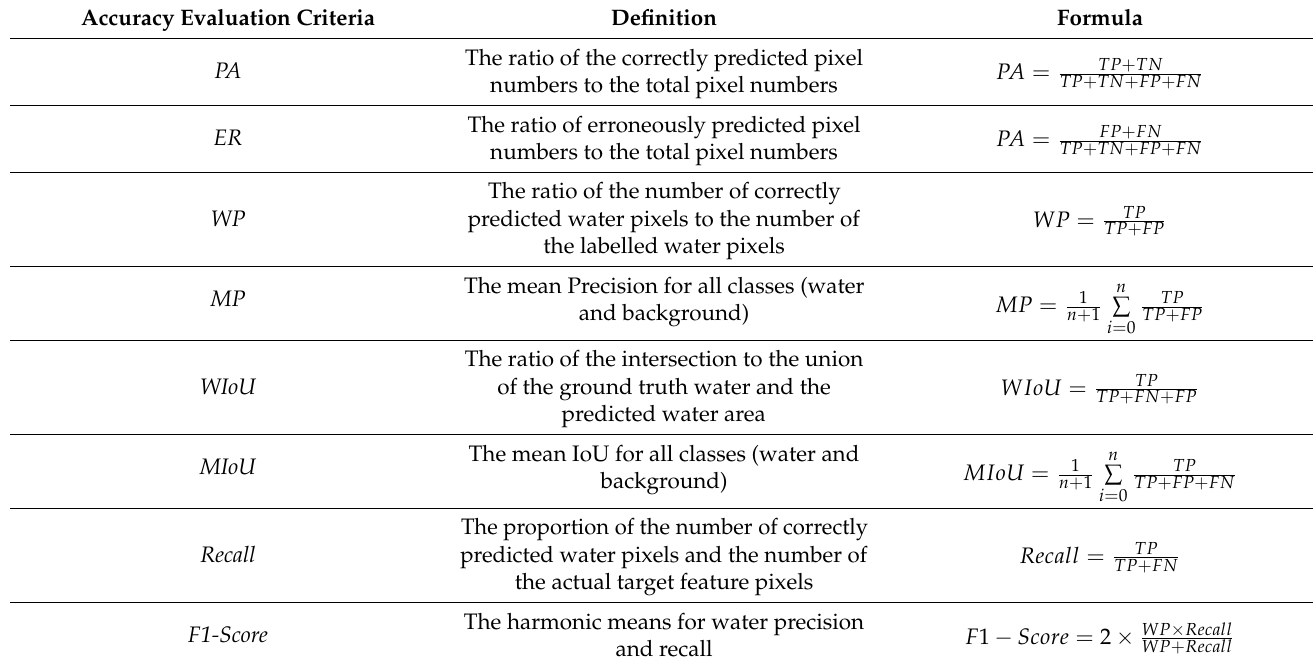
Table 5. Eight evaluation criteria for the accuracy assessment.